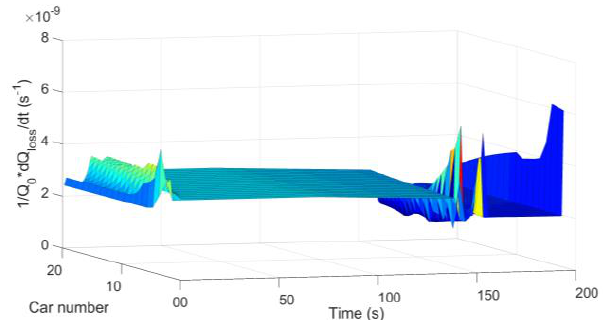
Figure 13. Vehicle battery capacity decline in situation 3.